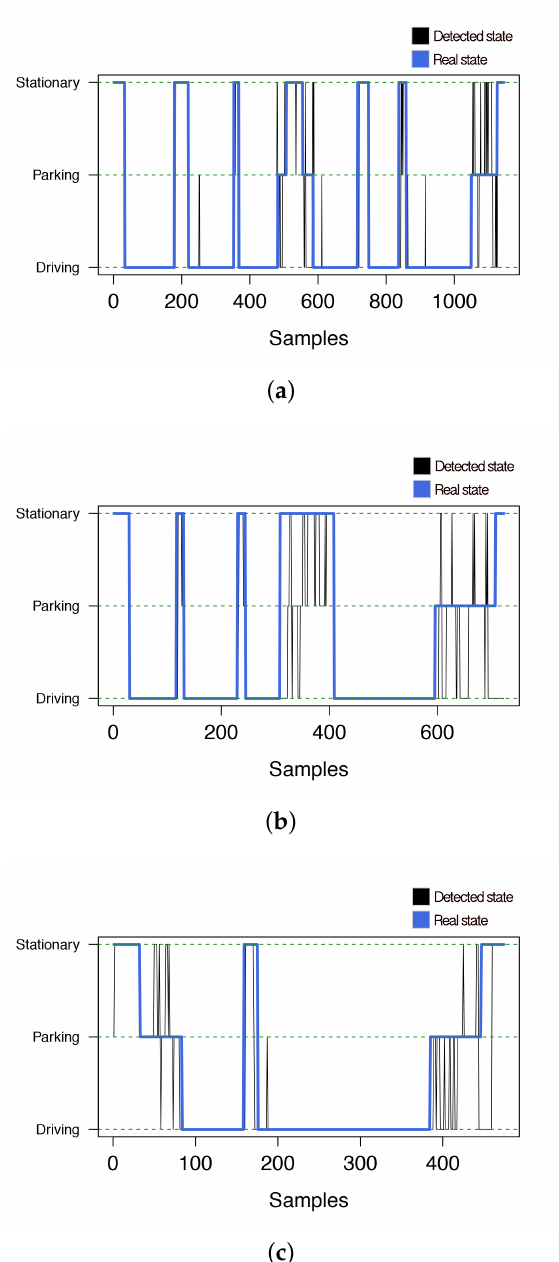
Figure 10. System predictions using breakout detection for the three target experiments. ( a ) Experiment E1; ( b ) Experiment E2; ( c ) Experiment